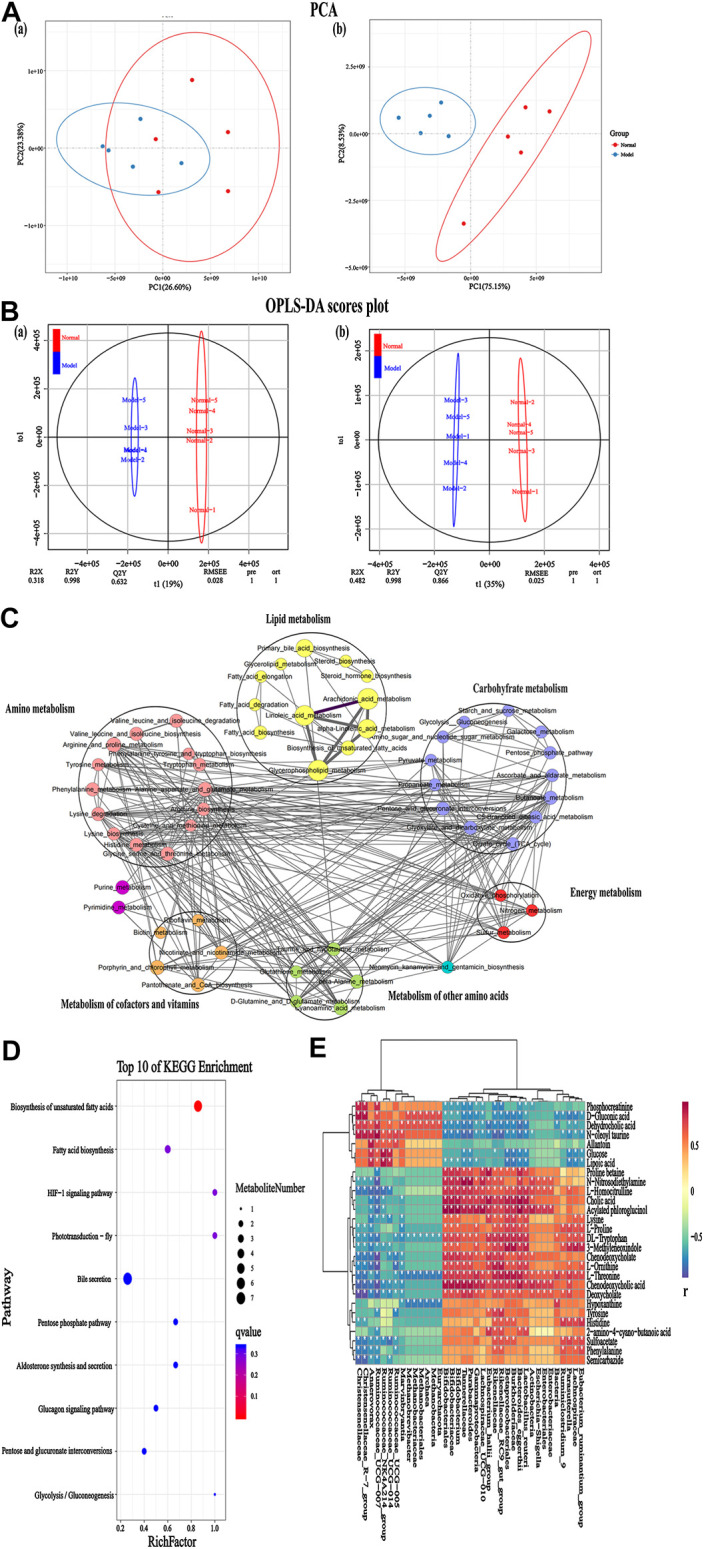
Serum metabolomics for identification of metabolites and metabolic pathways in the IgAN rats. (A) PCA plots [positive (A) and negative (B) ion mode] revealed that the overall metabolite profiles differed between the normal and model rats (n = 5). (B) OPLS-DA plots [positive (A) and negative (B) ion mode] with the scores of the first two principal components from the normal and model rats (n = 5). (C) Integrated metabolite pathway-based network analysis of serum metabolites using Cytoscape software, based on KEGG database. (D) Top 10 altered metabolites between the normal and model groups, based on KEGG pathway enrichment analysis and statistical significance. (E) Heatmap representing the correlation values between discriminant bacterial species and differential serum metabolites in the normal and model groups. Asterisks represent the significance level of the corresponding correlation coefficient, *p < 0.05.